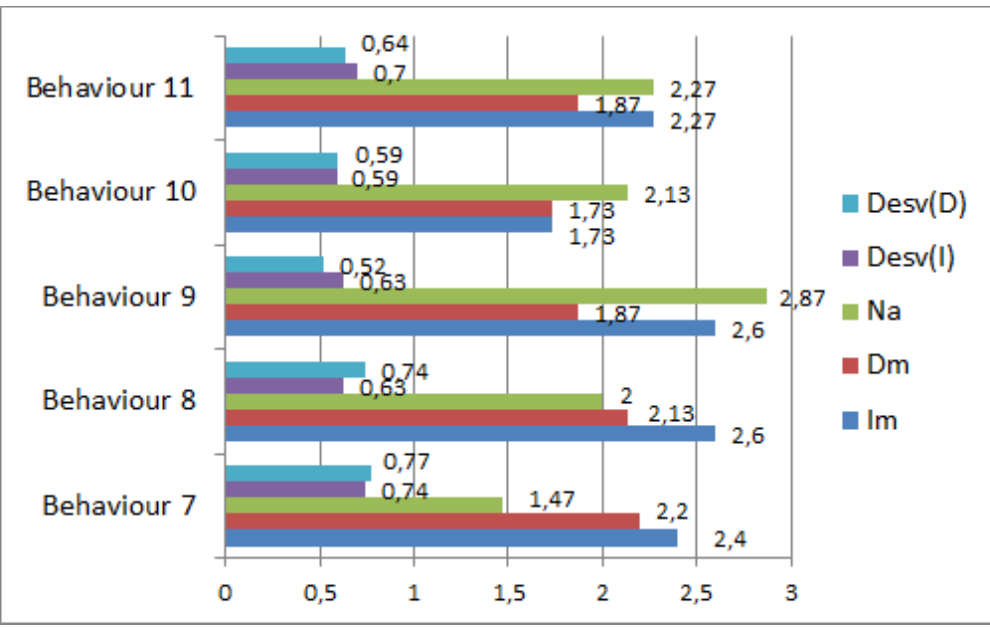
Figure 2. Conflict